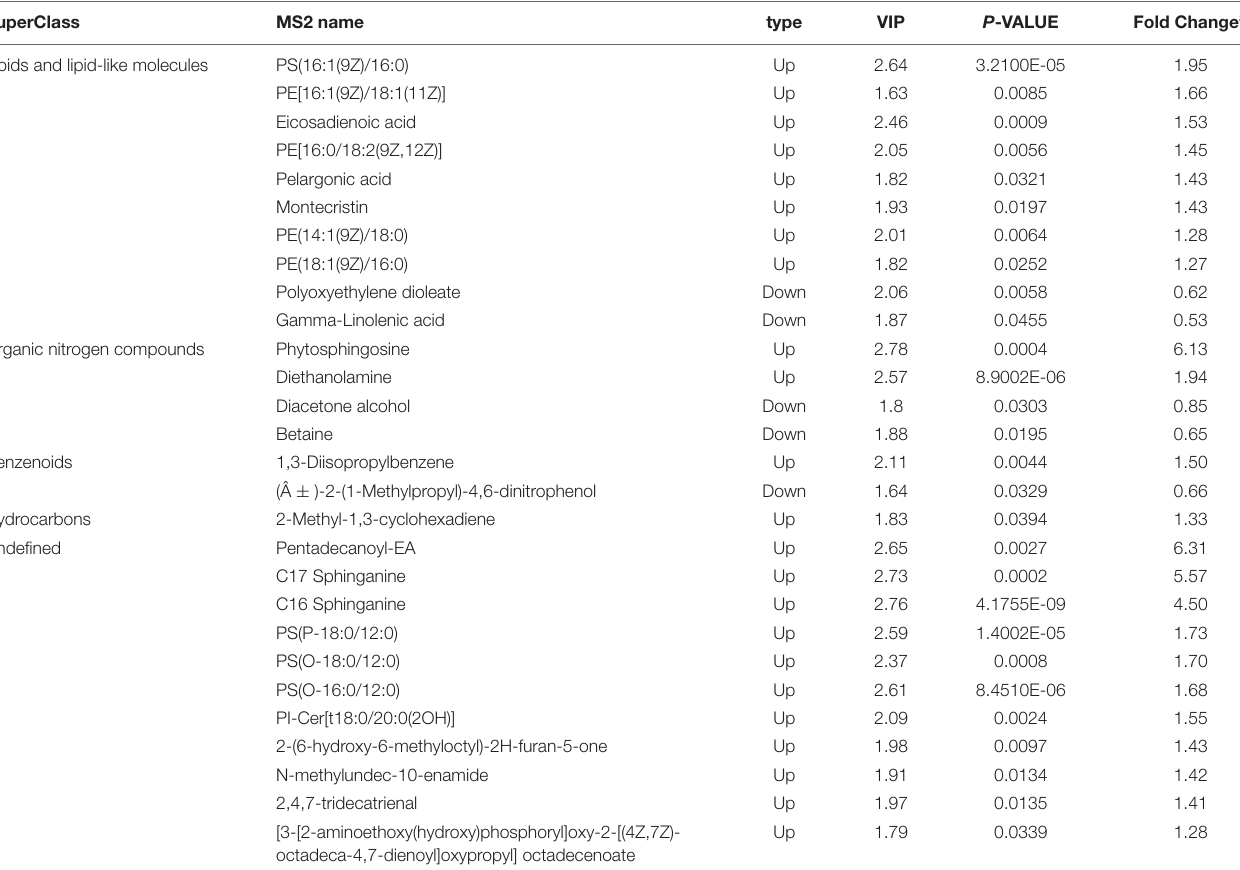
TABLE 2 | Differentially expressed metabolites between Polymyxin B (PB) resistant and susceptible Klebsiella